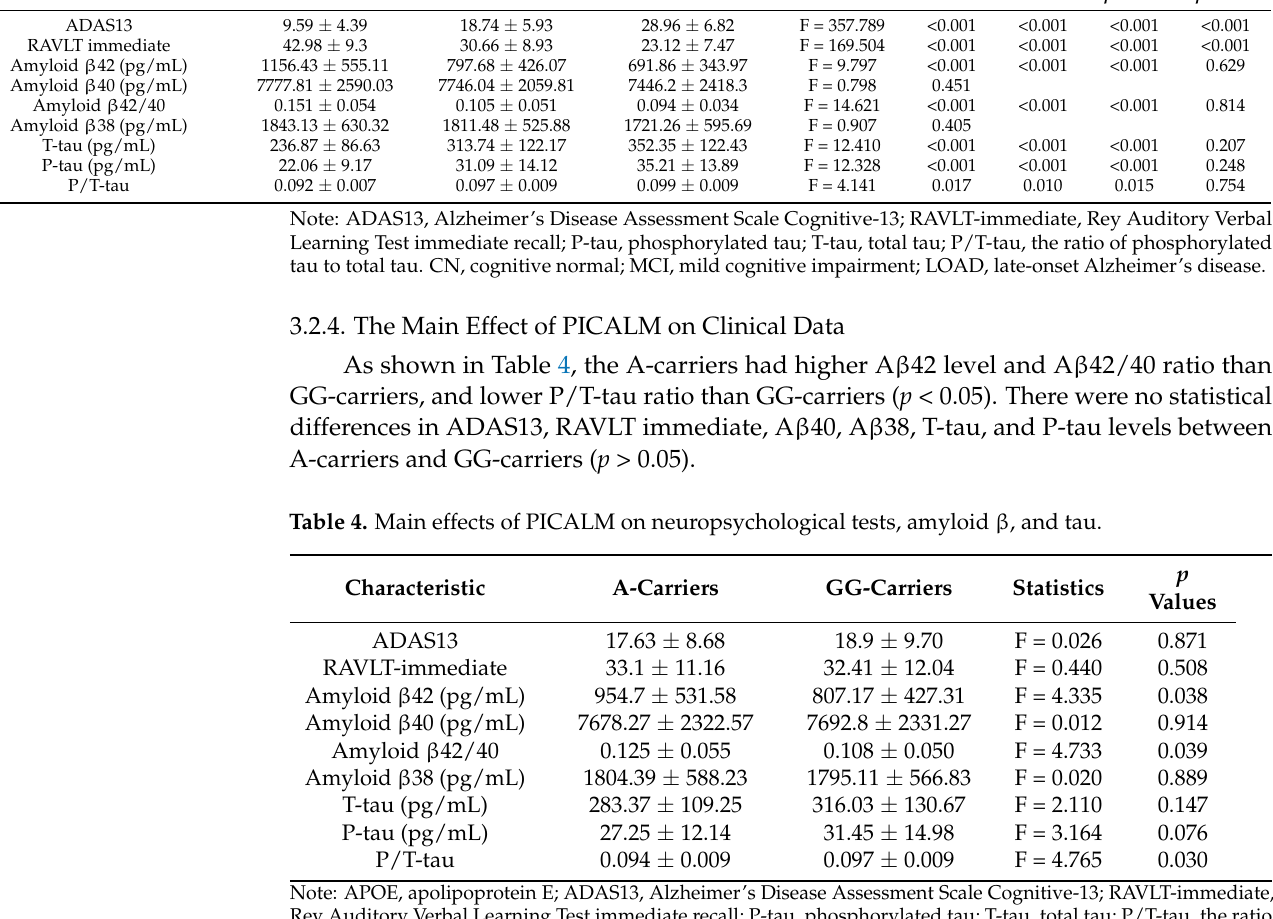
Table 3. Main effects of Diseases on neuropsychological tests, amyloid β , and tau. Characteristic CN MCI LOAD